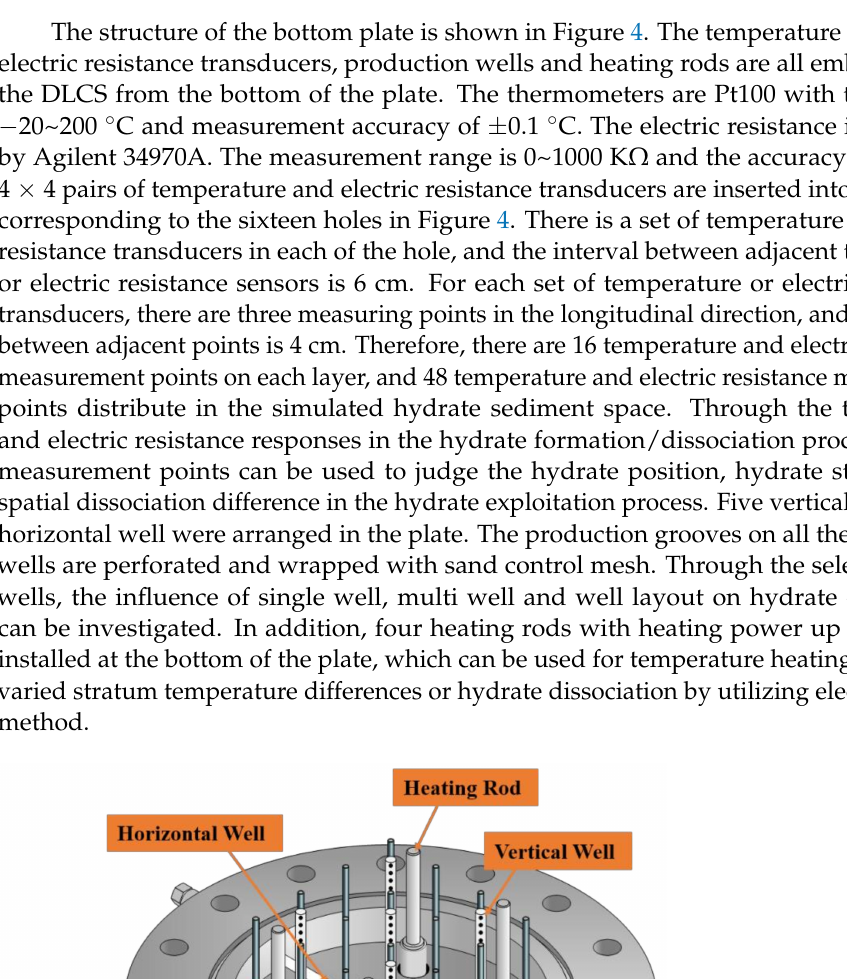
Figure 3. The movable flashboard for dynamic separation and natural contact of hydrate-bearing sediment and its overlying strata.